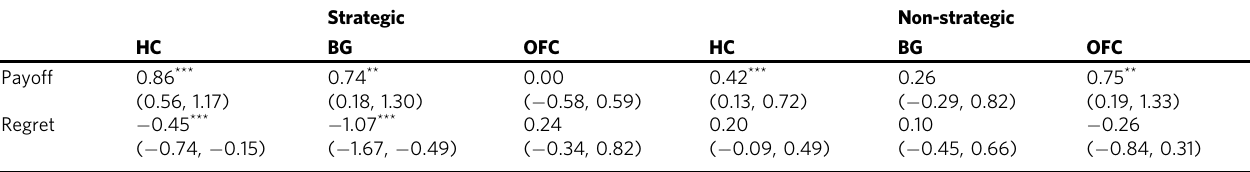
Table 1 Logistic regression modeling of effect of received payoff and regret on subsequent stay/switch decisions